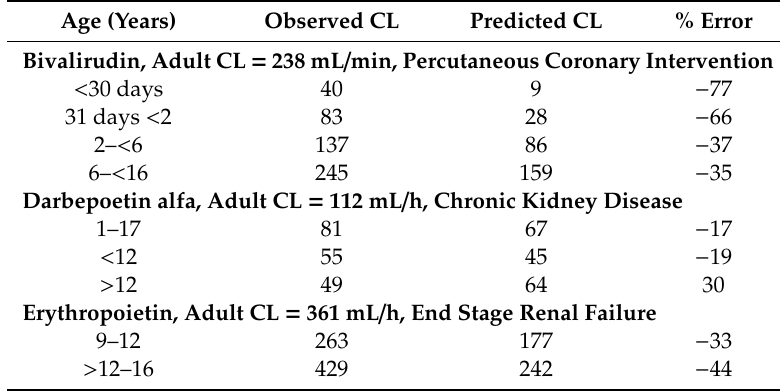
Table 3. Predicted and observed clearance of therapeutic proteins (non-antibodies) in children of di ff erent